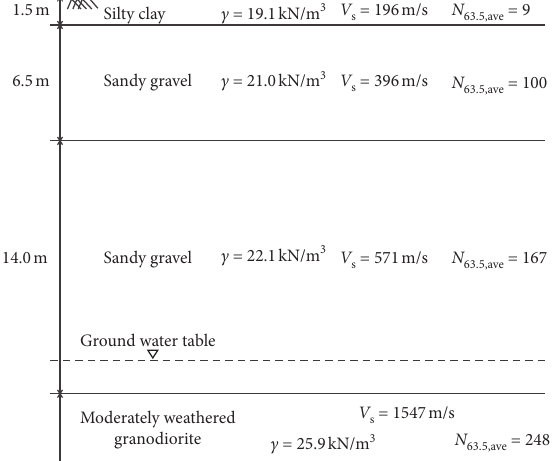
Figure 4: Soil profile of the construction